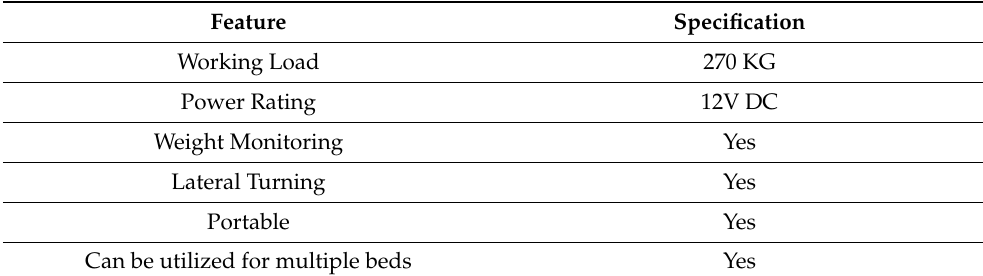
Figure 1. Graphical representation of proposed methodology. Table 1. Specifications of the proposed system.